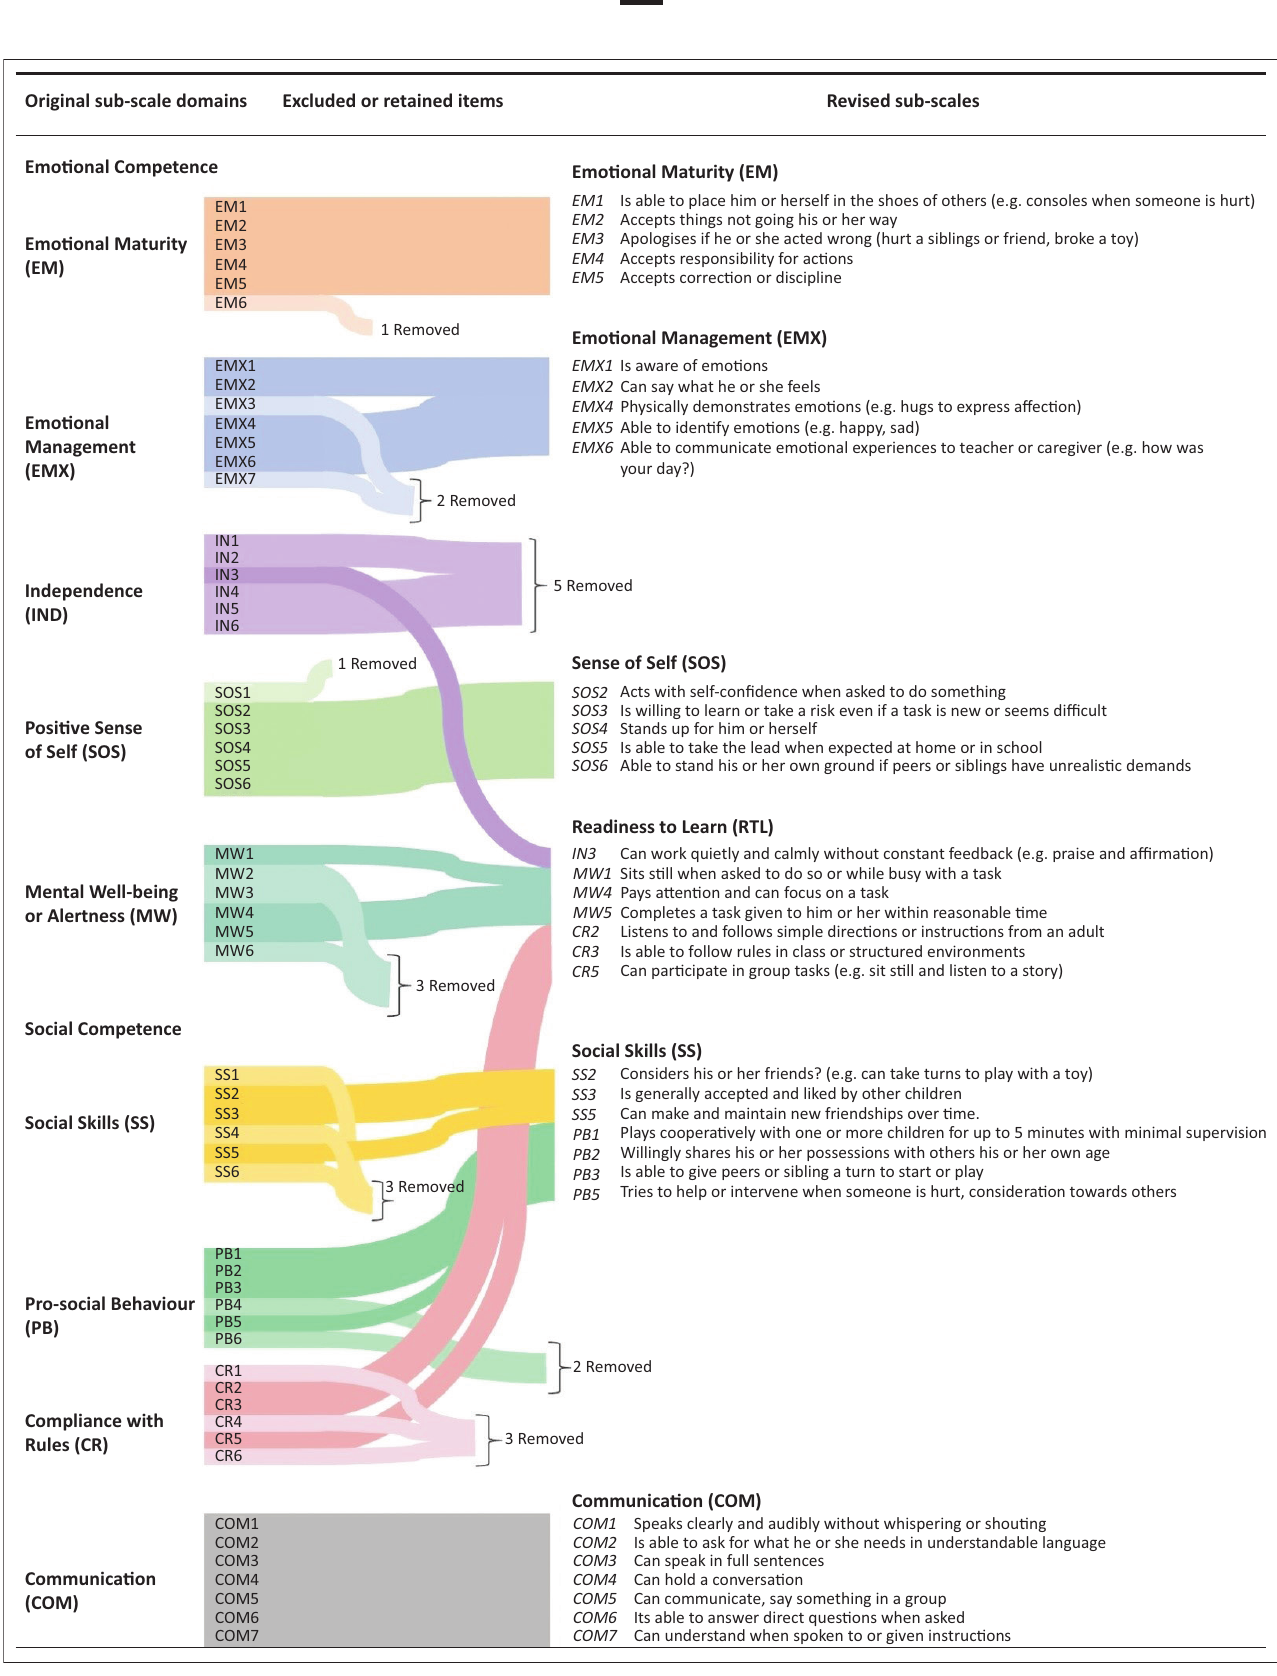
Compliance with Rules highlighted the interdependent nature of these constructs. The attributes of these sub-domains spoke of the child’s general readiness for learning, including their